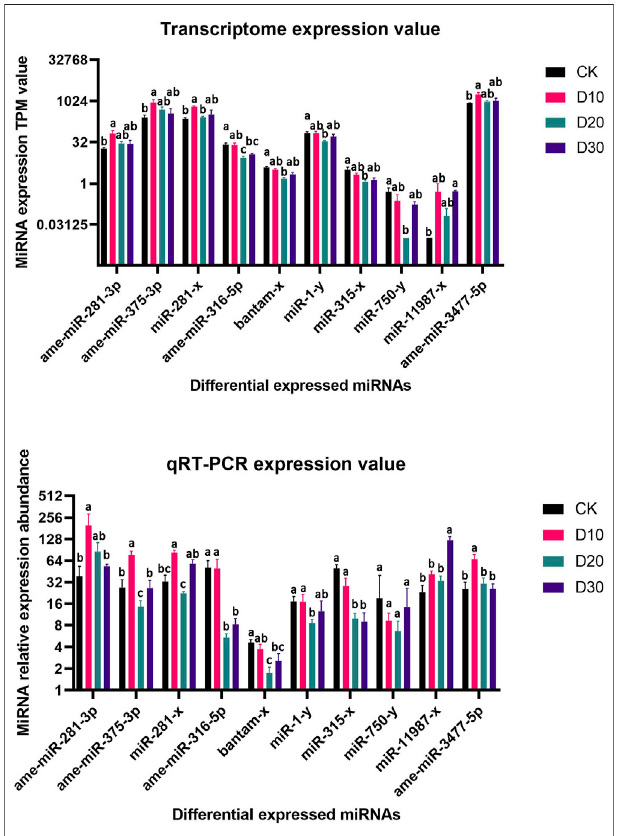
FIGURE 2 | RNA-Seq and qRT-PCR relative expression level of differentialexpressedmiRNAs. (A) MiRNAexpressionTPMvalueofRNA-Seq, (B) MiRNA relative expression level of qRT-PCR. Signi fi cant differences are indicated by different symbols with FDR < 0.05 in RNA-Seq results and p < 0.05 in qRT-PCR